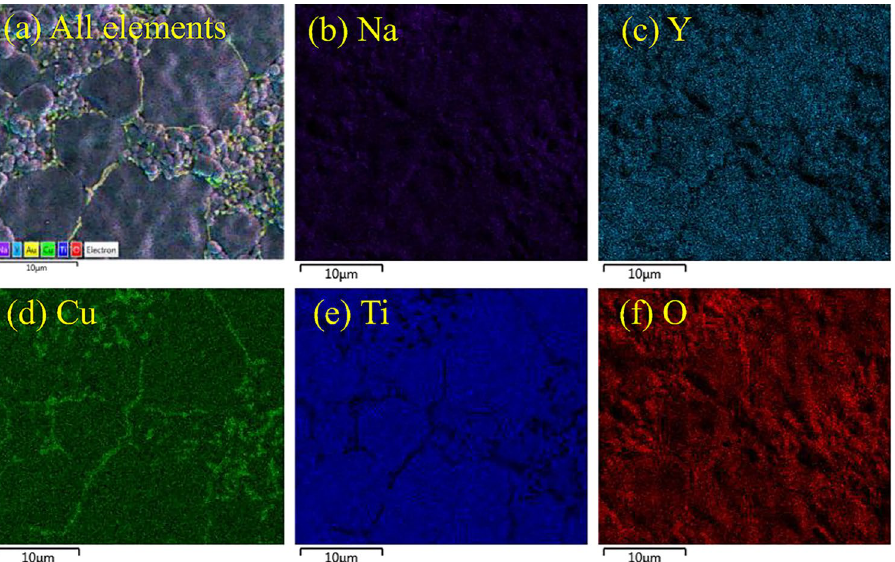
Figure 3. EDS mapping of the NY9h ceramic. Distribution of ( a ) all elements, ( b ) Na, ( c ) Y, ( d ) Cu, ( e ) Ti and ( f ) O elements in the NY9h